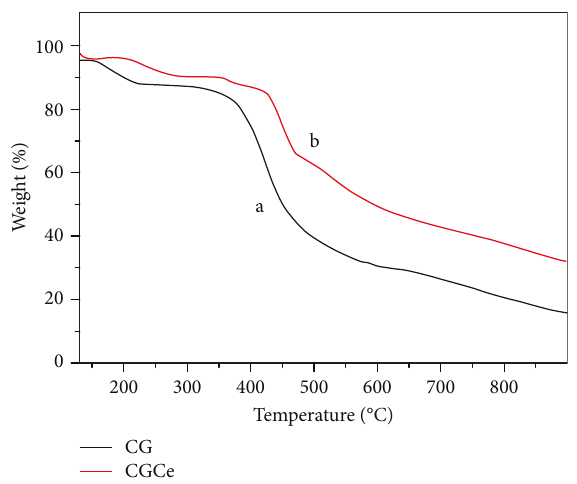
Figure 3: TGA test of CG and CGCe.